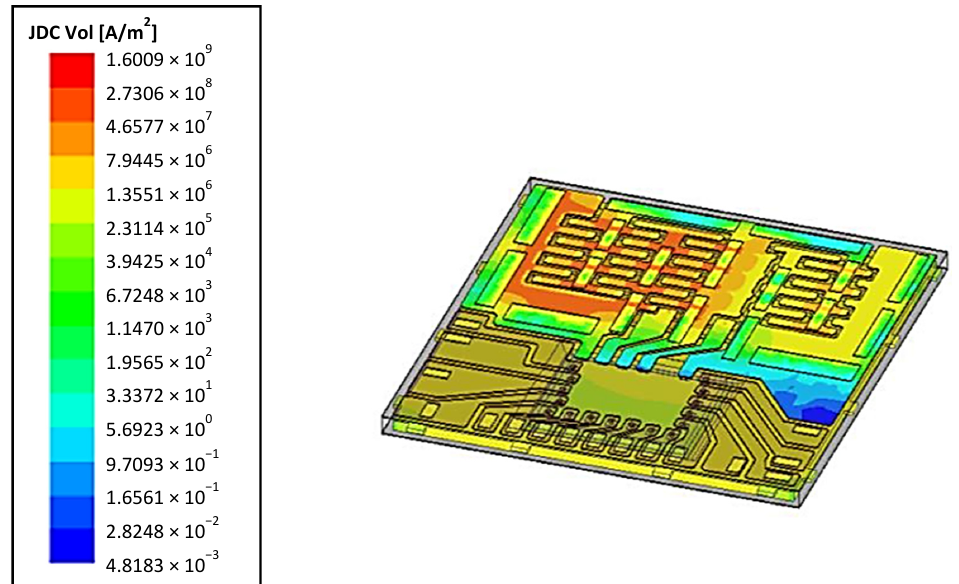
Figure 5. Voltage map, with a current equal to 90 A at 500 kHz as input.